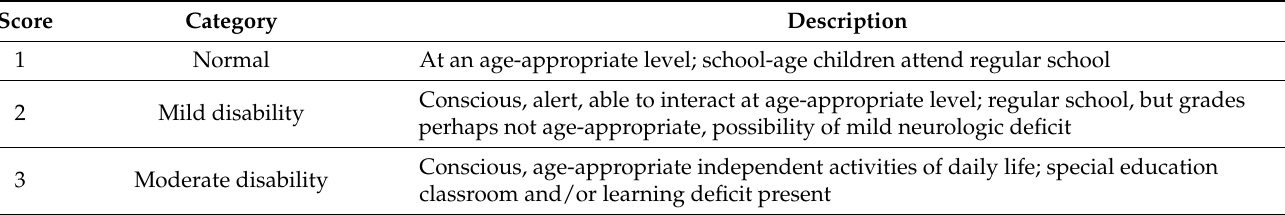
Table 6. PCPC Scale